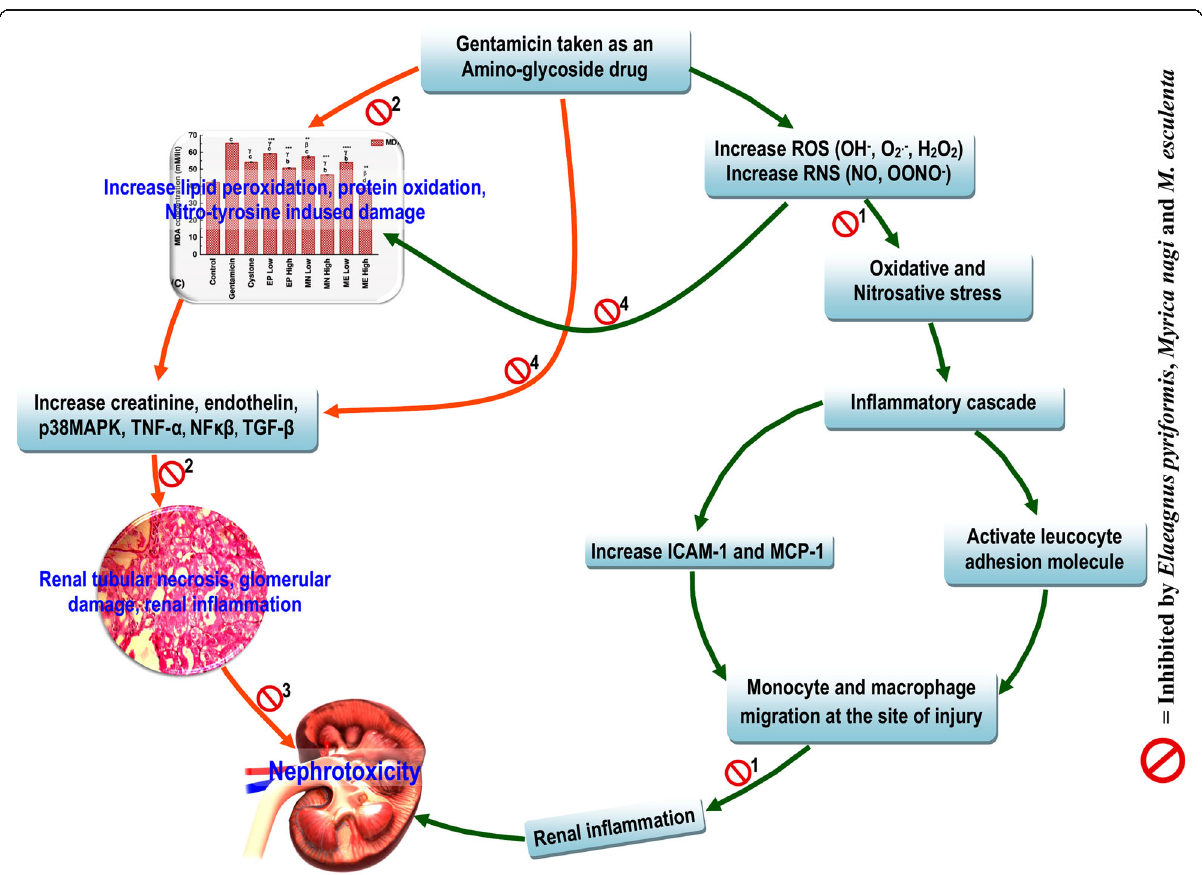
Fig. 5 Schematic representation showing role of gentamicin in the induction of nephrotoxicity and the role of phytocompounds from the three actinorhizal fruits showing activity to reduce the nephrotoxicity. Numbers beside Ø indicate the phytochemicals present in the three juices: 1 = γ - Sitosterol; 2 = n-Hexadecanoic acid; 3 = Octadecanoic acid; 4 = 1,2-Longidione. MAPK = mitogen activated protein kinase; TNF- α = tumor necrosis factor alpha; NF κβ = Nuclear factor kappa beta; TGF- β = Transforming growth factor beta; ICAM-1 = Intercellular cellular adhesion molecule-1; MCP-1 = Monocyte chemoattractant protein-1; O 2 − = Superoxide radical; OH − = Hydroxyl radical; H 2 O 2 = Hydrogen peroxide; NO= Nitric oxide; OONO − = Peroxynitrate; ROS = Reactive oxygen species; RNS = Reactive nitrogen